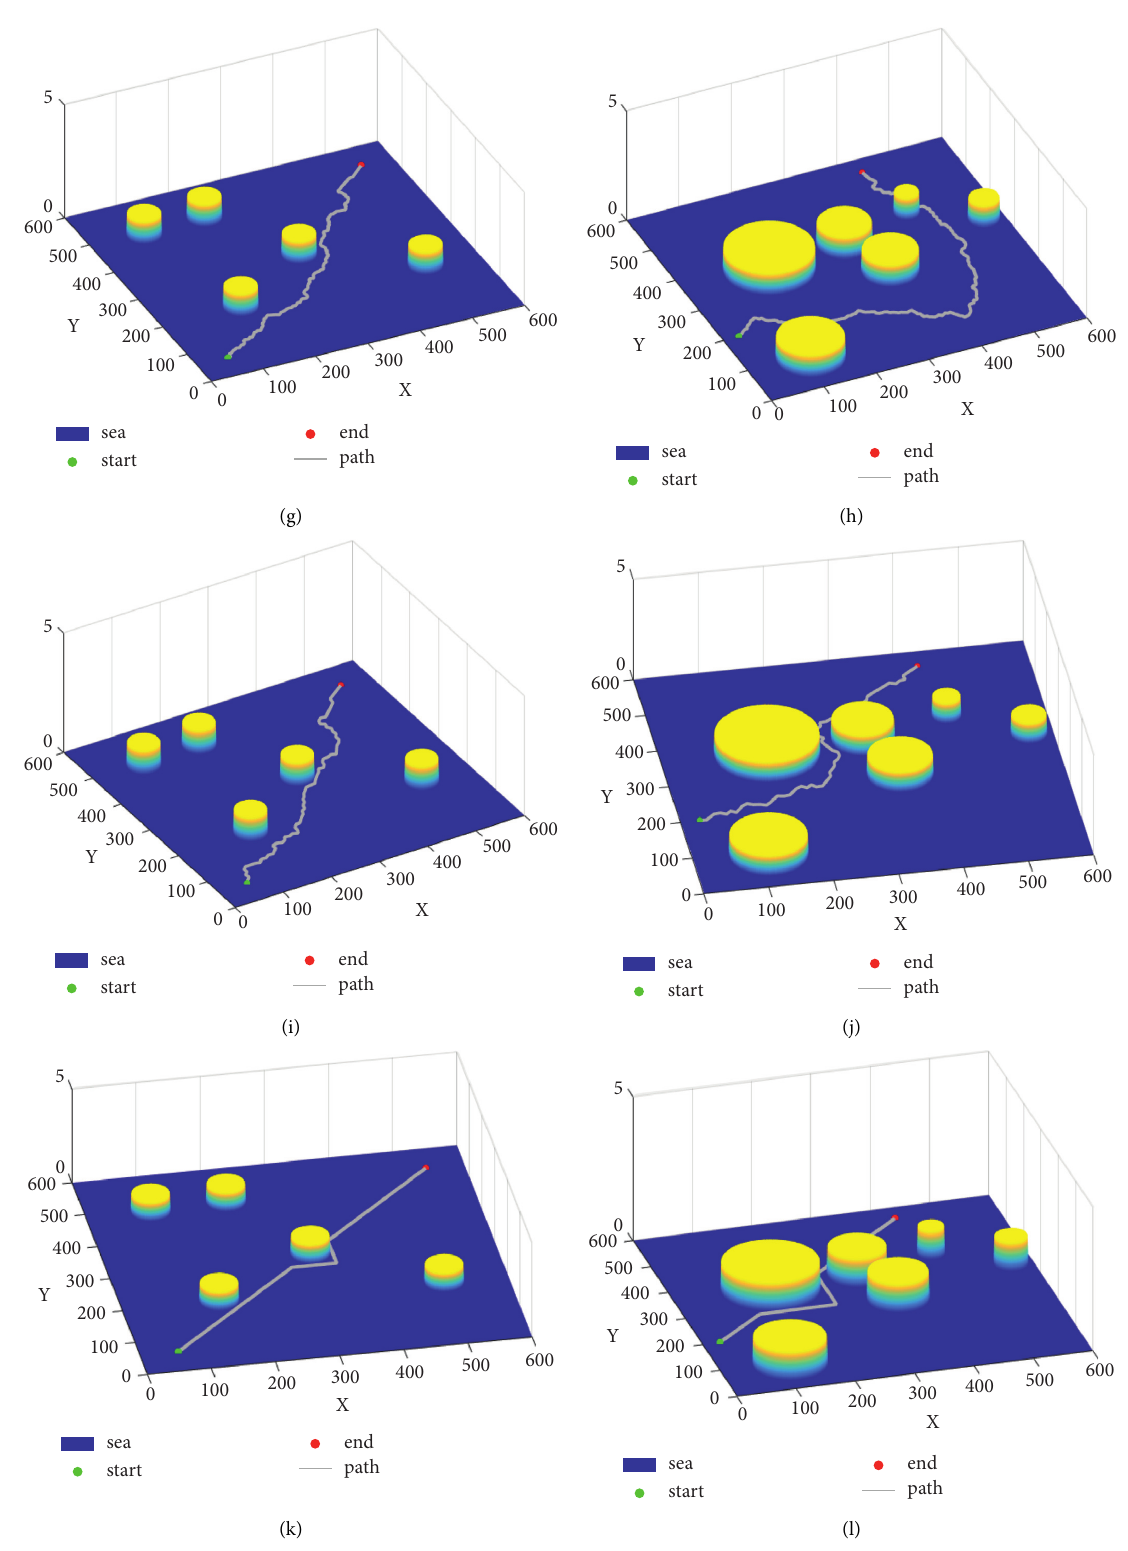
Figure 17: Paths planned for different environments. (a) The path planned by this paper algorithm in environment 1. (b) The path planned by this paper algorithm in environment 2. (c) The path planned by APF algorithm in environment 1. (d) The path planned by APF algorithm in environment 2. (e) The path planned by A ∗ algorithm in environment 1. (f) The path planned by A ∗ algorithm in environment 2. (g) The path planned by RRTalgorithm in environment 1. (h) The path planned by RRTalgorithm in environment 2. (i) The path planned by RRT ∗ algorithm in environment 1. (j) The path planned by RRT ∗ algorithm in environment 2. (k) The path planned by BUG2 algorithm in environment 1. (l) The path planned by BUG2 algorithm in environment